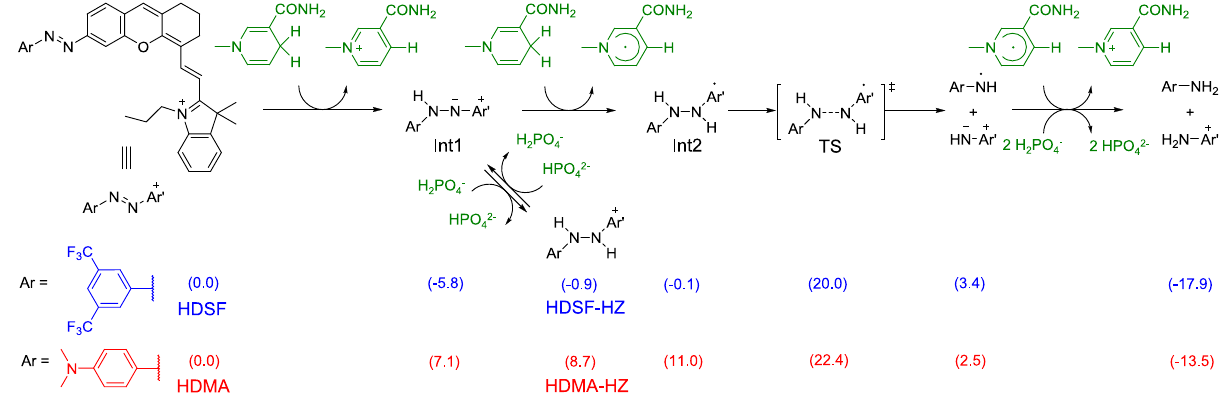
Fig. 3 DFT-calculated free energies for the reduction processes of HDSF and HDMA. Numbers in parentheses are in kcal/mol, which are free energies of HDSF reduction intermediates and products (blue color) or HDMA reduction intermediates and products (red